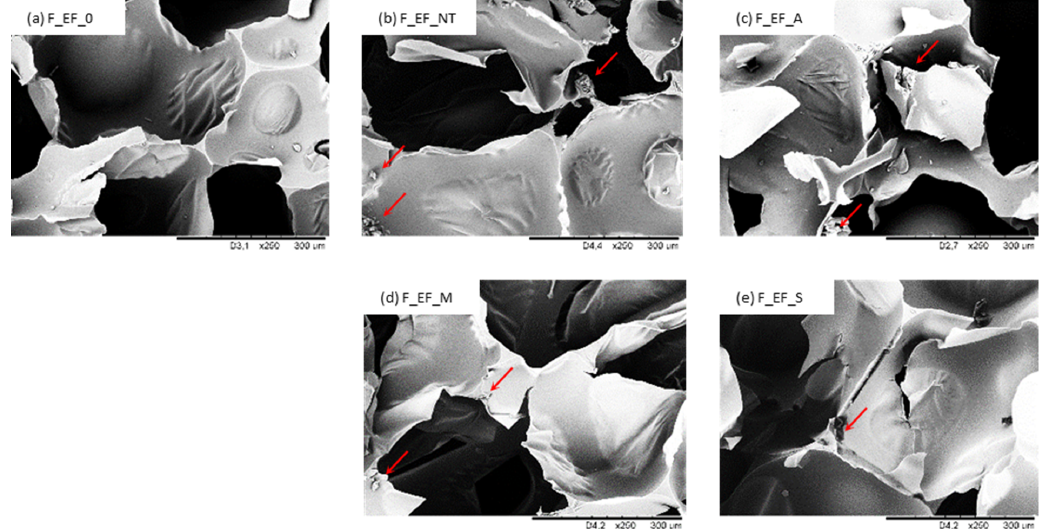
Figure 11. The morphology of ( a ) F_EF_0, ( b ) F_EF_NT, ( c ) F_EF_A, ( d ) F_EF_M, ( e ) F_EF_S observed at a magnification of ×200.